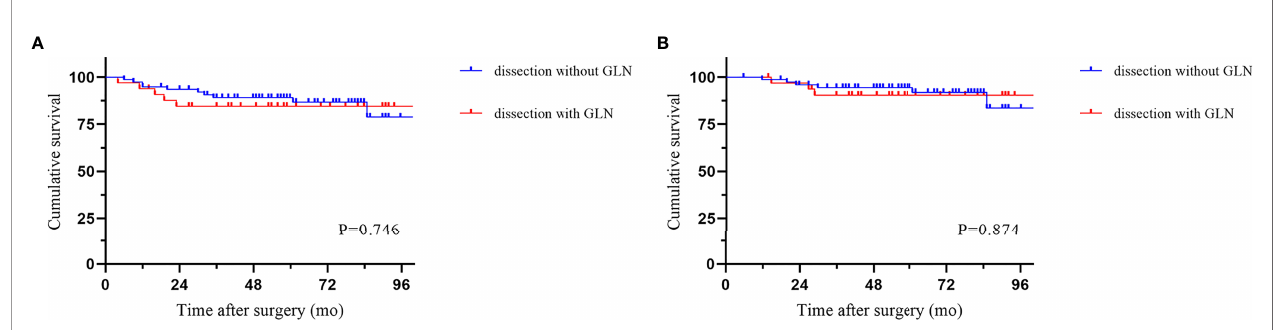
FIGURE 4 | Survival according to whether gastroepiploic lymph nodes were dissected. (A) Disease-free survival. (B)